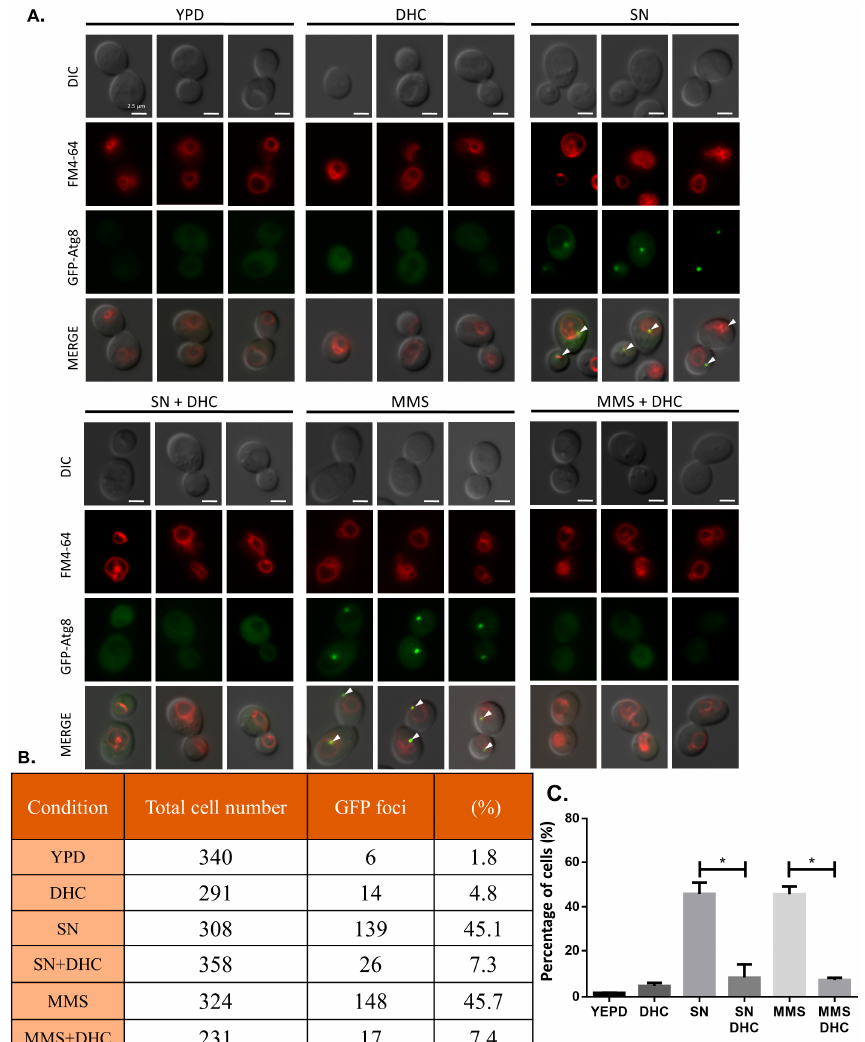
Figure 8. DHC inhibits nitrogen starvation and MMS-induced autophagy. ( A ) GFP-Atg8 (RLY004) cells were cultured in YPD, nitrogen starvation (SN) conditions, MMS (0.1%), DHC (5 mM), SN + DHC and MMS + DHC for 4 h. Samples were stained with FM4-64 and processed for fluorescence